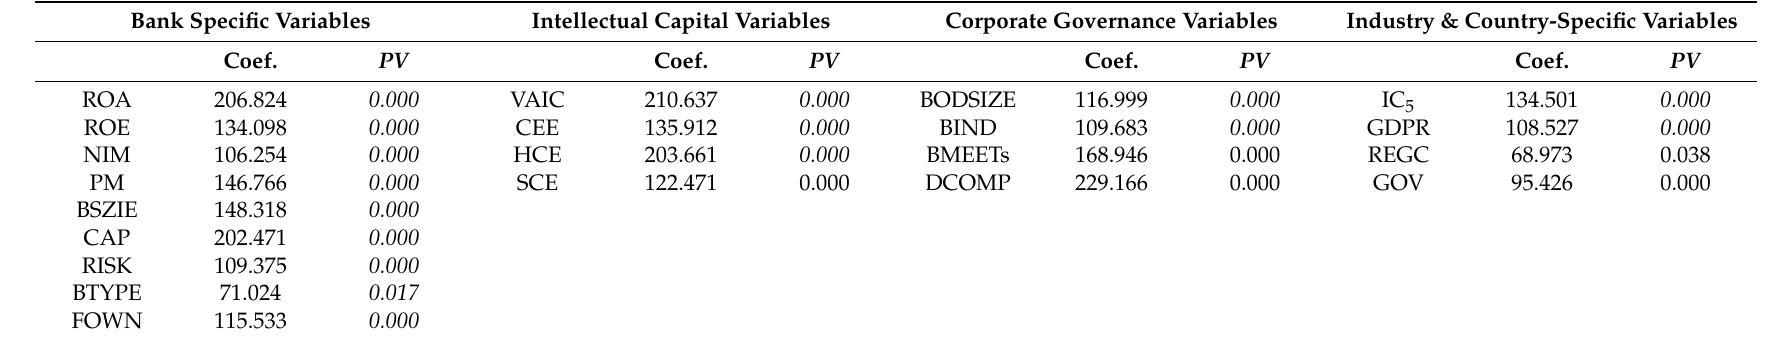
Table 3. Unit root test (Augmented Dickey Fuller-ADF).